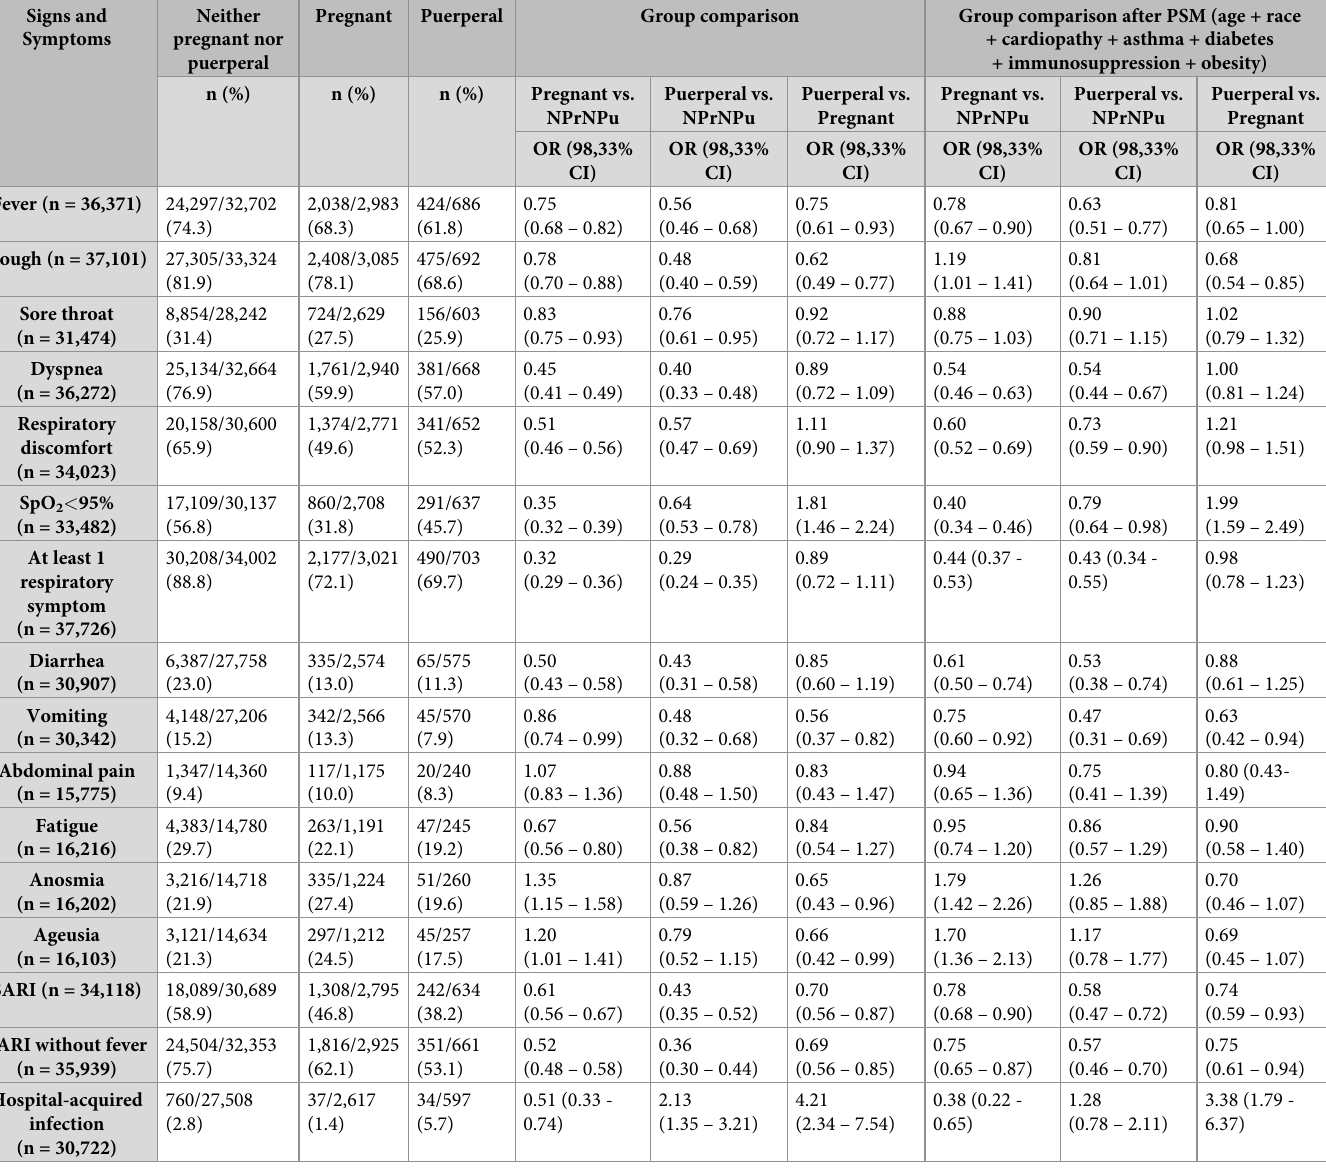
Table 2. COVID-19 signs and symptoms in pregnant, puerperal, and neither pregnant nor puerperal reproductive age women before and after propensity score matching – Brazil, February 17, 2020 – January 02, 2021. Signs and Pregnant Puerperal Group comparison Group comparison after PSM (age + race Symptoms